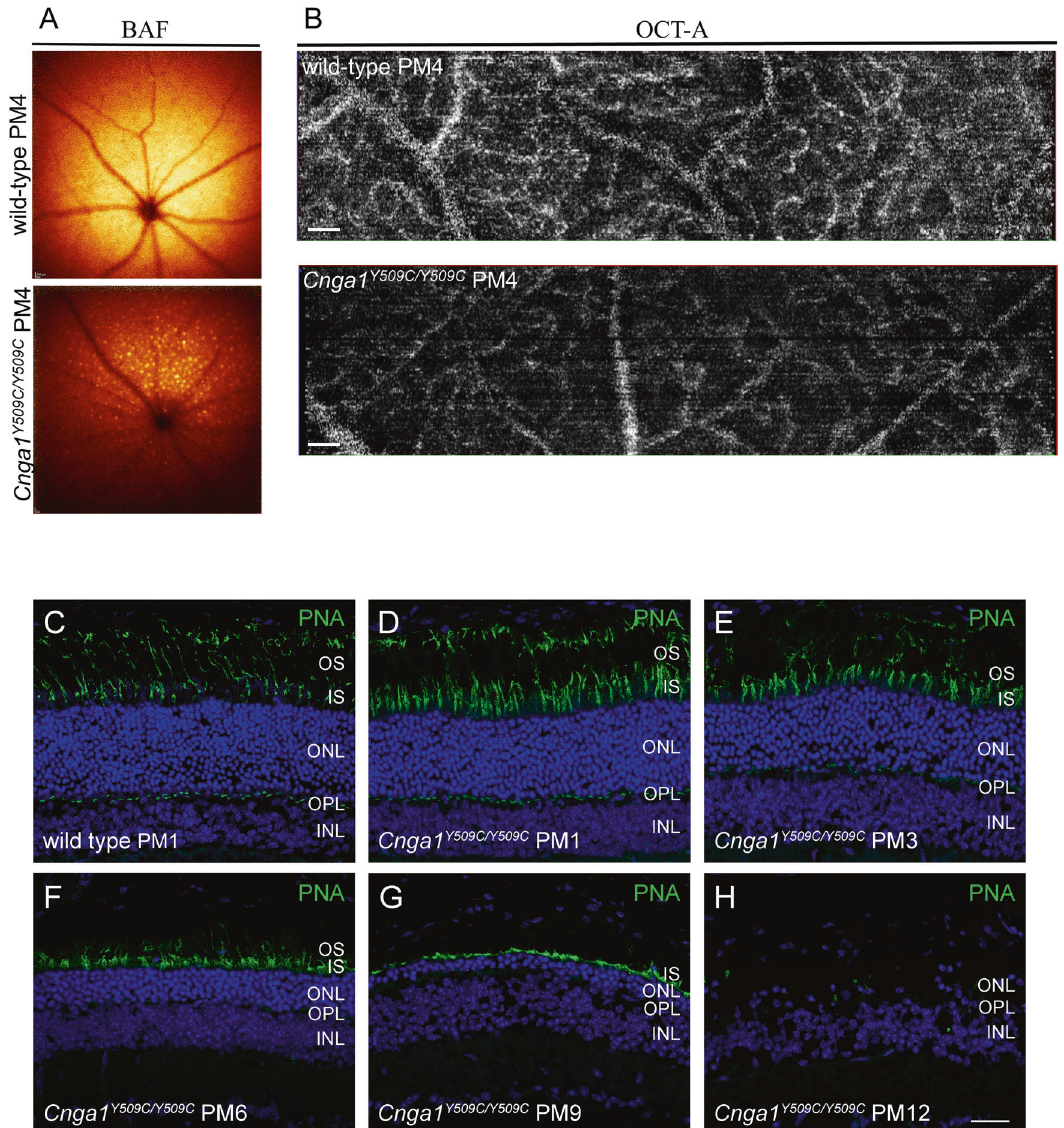
Fig. 7 Cnga1 Y509C/Y509C mice show secondary retinal morphological changes and degeneration of cone photoreceptors. Representative BAF and OCT-A scans of the fundus ( A ) and retinal vasculature ( B ) showing accumulation of auto fl uorescent spots and altered vascular bed in the Cnga1 Y509C/Y509C mouse fundus. Representative confocal images showing expression of peanut agglutinin (PNA; green) in retinal cross sections of wild-type (1 month postnatal (PM1); ( C ) and Cnga1 Y509C/Y509C mouse retinas ( D – H ) at PM1, PM3, PM6, PM9 and PM12 demonstrating a degeneration of cone photoreceptors with age. Scale bars in B marks 200 µm. Scale bar in H marks 25